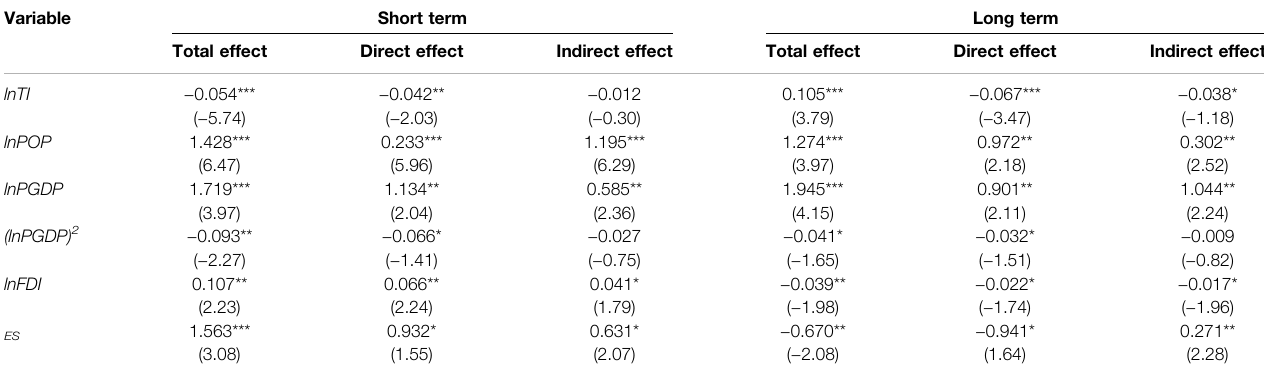
TABLE 5 | Decomposition effects of low-carbon tech-innovation on haze pollution (W 1 ). Variable